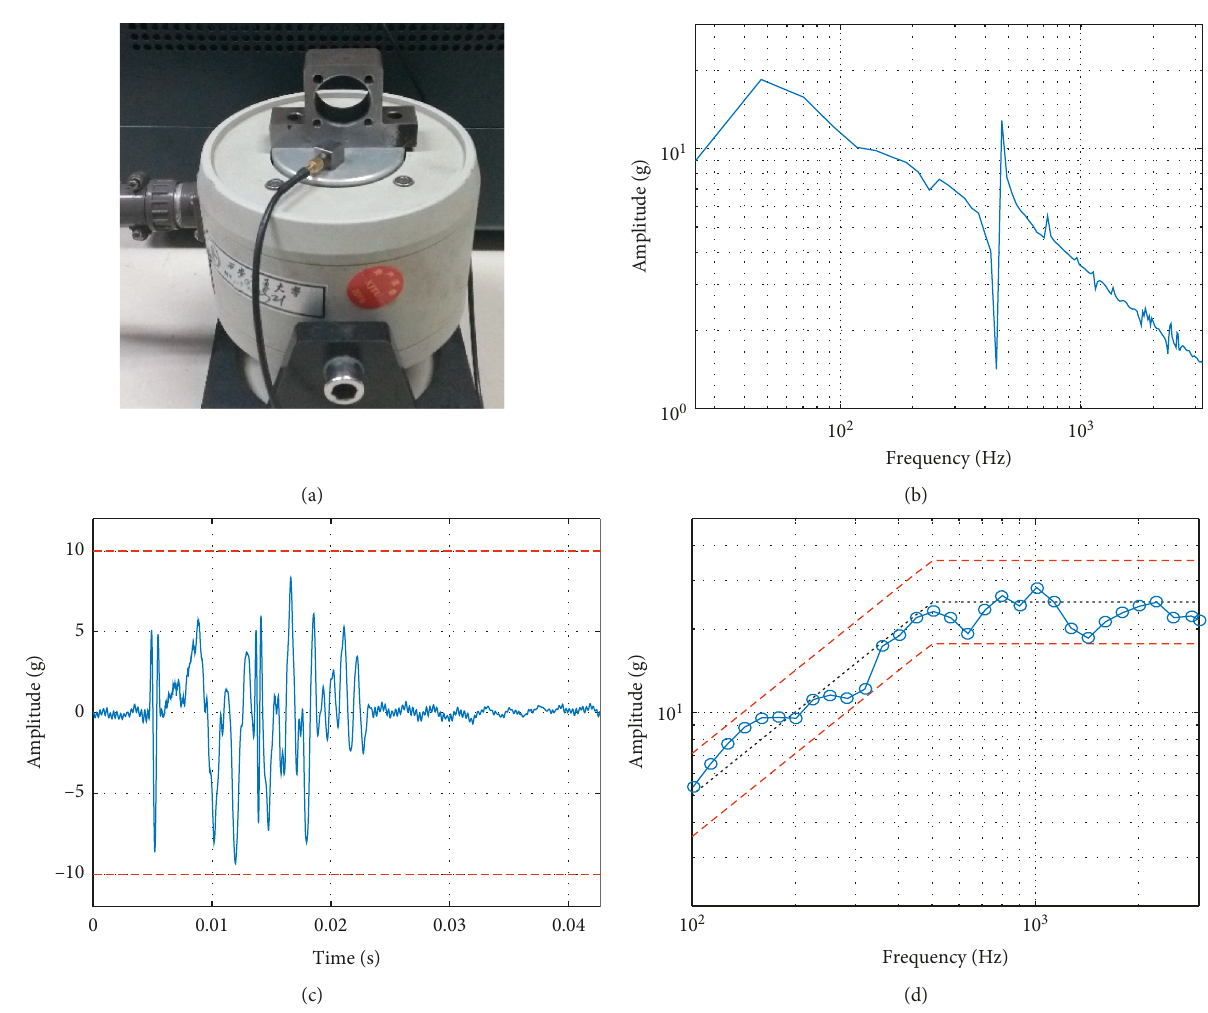
Figure 12: Case C: SRS experimental test with heavy load. (a) Shaker; (b) FRF; (c) waveform; (d)